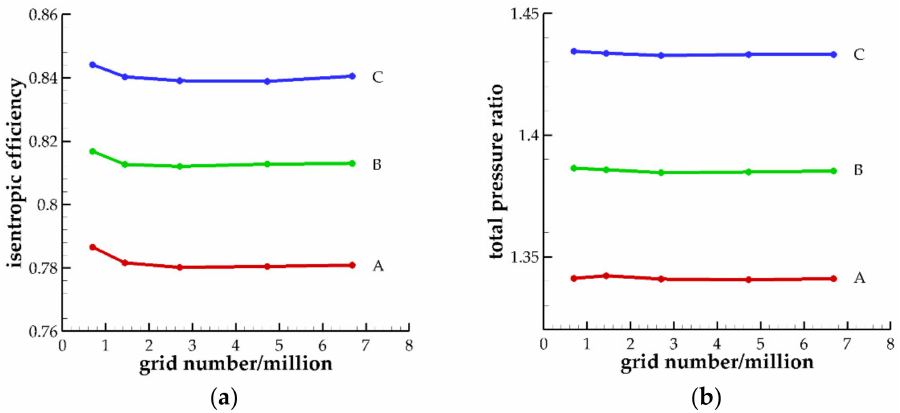
Figure 3. Validation of grid independence of the research compressor. ( a ) Isentropic Efficiency;